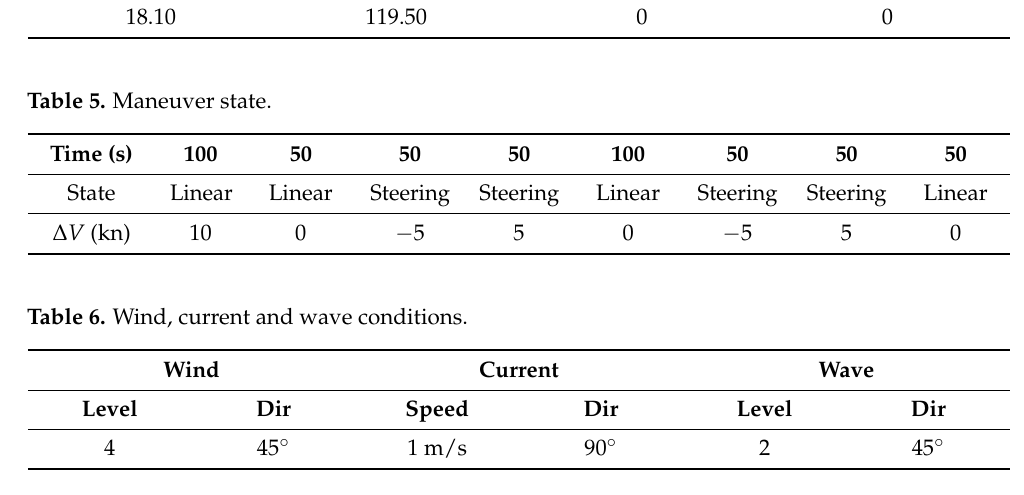
Table 4. Ship’s initial condition.